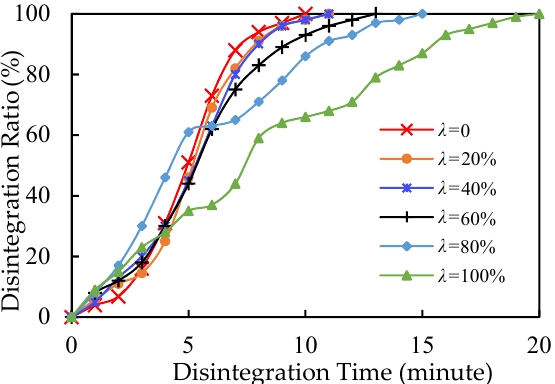
Figure 7. Relationship between disintegration ratio and time of mixed soil.